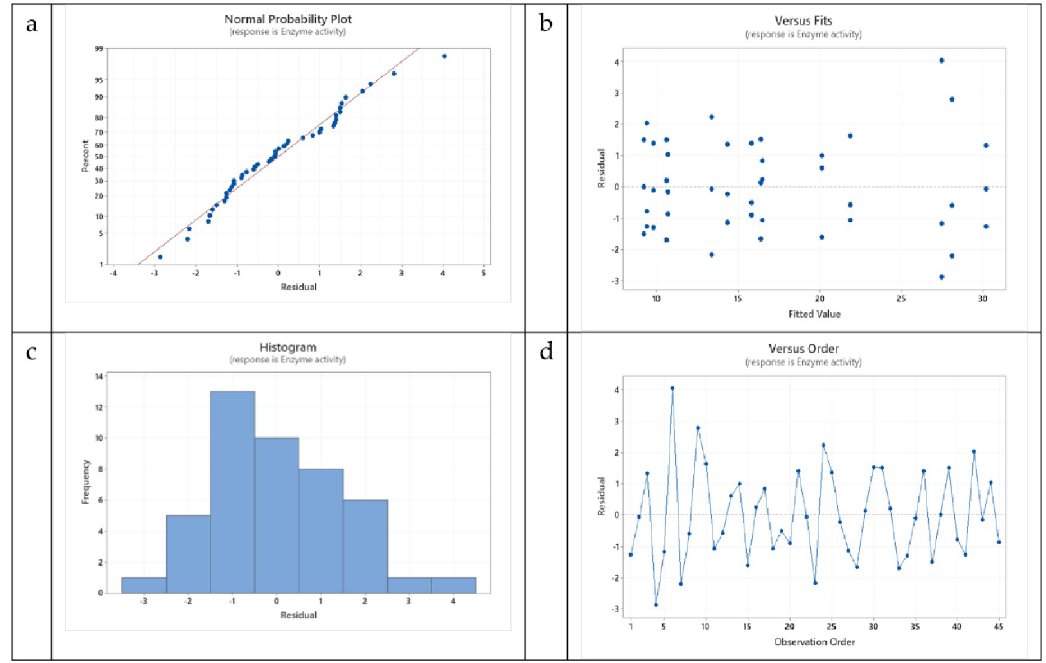
Fig 1. (a) Normal probability plot for residual value, (b) residual plots against fitted value, (c) histogram of residual value, (d) residual plot against observation order of individual fungi and fungal consortium producing cellulase.